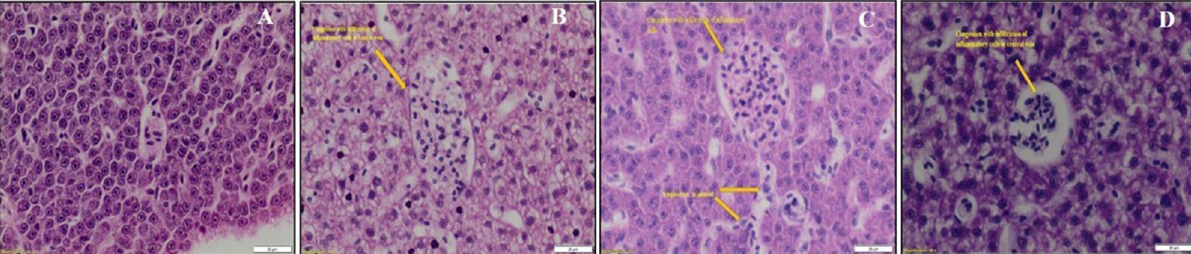
Figure 6. Histopathology changes in the liver of Zebrafish. Representative image of liver stained with Hematoxylin (purple color-nuclei) and eosin (pink color-cytoplasm). ( A ) Untreated liver ( B ) Doxycycline ( C ) KF@AgNPs and ( D ) KF@CuNPs treated.